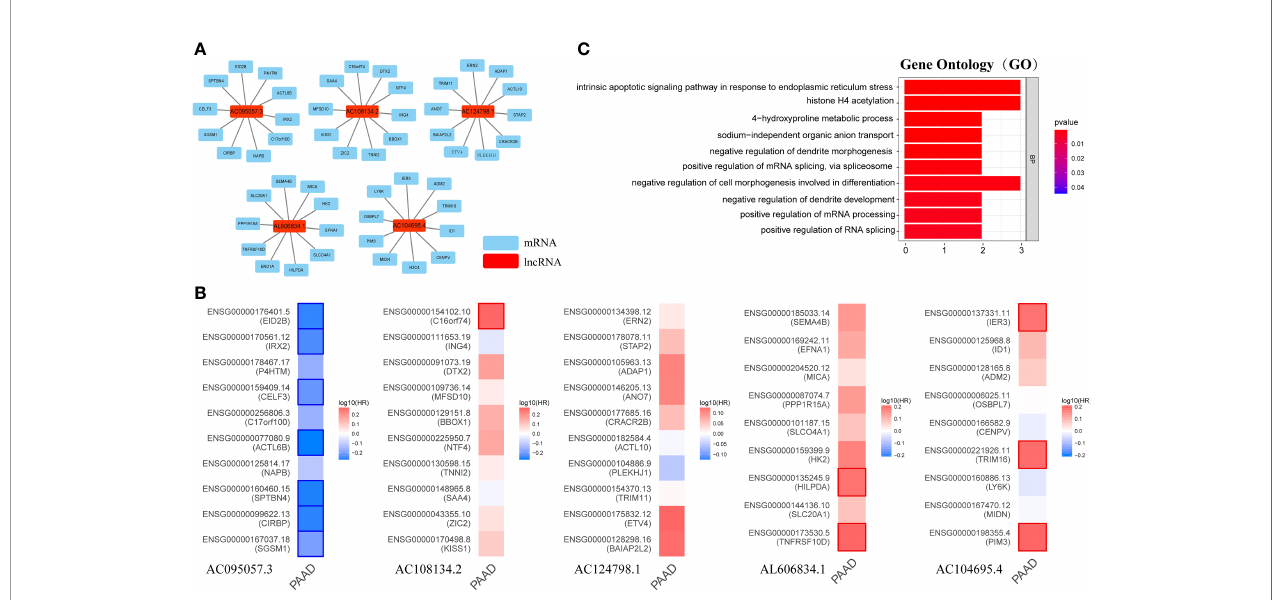
FIGURE 9 | Possible function associated with GILncSig. (A) GILncRNA-mRNA co-expression network. (B) The GEPIA2 server makes survival maps for the mRNAs related to AC095057.3, AC108134.2, AC124798.1, AL606834.1, and AC104695.4 respectively (Blue and red boxes represent statistically signi fi cant differences in survival analysis; Mantel – Cox test). (C) GO term enrichment analysis of mRNA co-expressed with GILncRNA. Ten functions that are most relevant to GILncSig were shown through the co-expressed mRNAs enriching in the biological process (BP) of GO.